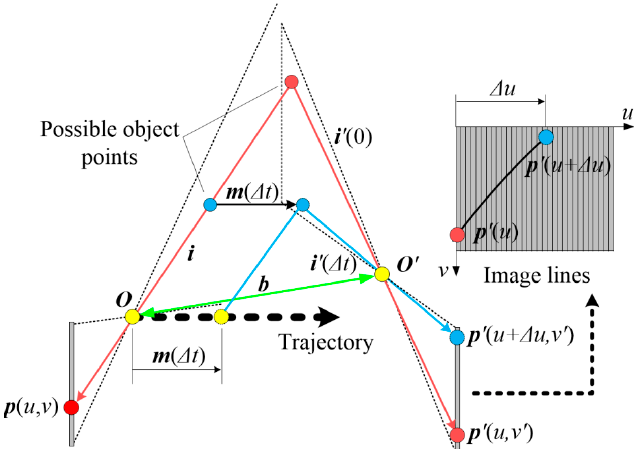
Figure 3. Locus of all possible conjugate points to a selected point.